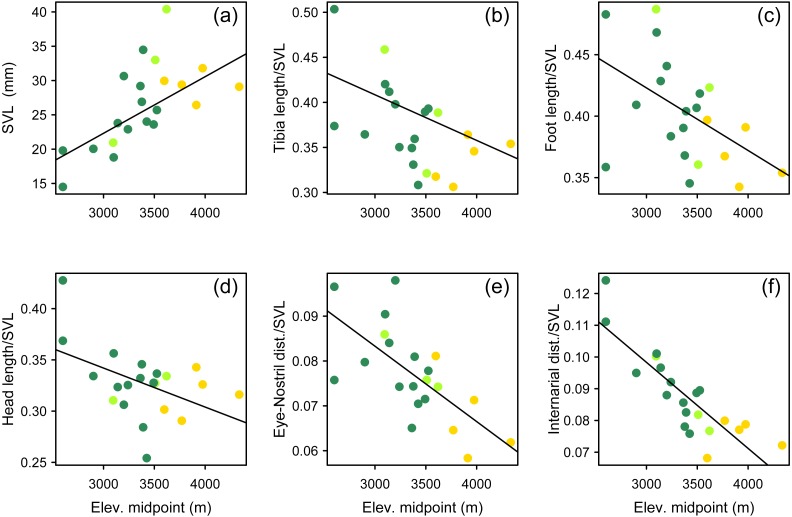
Multipanel plot morphology vs elevation.Body size and body shape in Phrynopus vary across elevations. Body size (A) tends to increase with increasing elevation. In contrast, when controlling for body size, species at higher elevations tend to be characterized by shorter limbs (B, C), shorter head (D), shorter snout (E), and narrower snout tips (F) than species living at lower elevations. Species are color-coded according to habitat use: Andean grassland (yellow), montane forest (dark green), and both habitats (light green). The regression lines reflect the phylogenetic correction. Based on dataset containing measurements from adult females only.